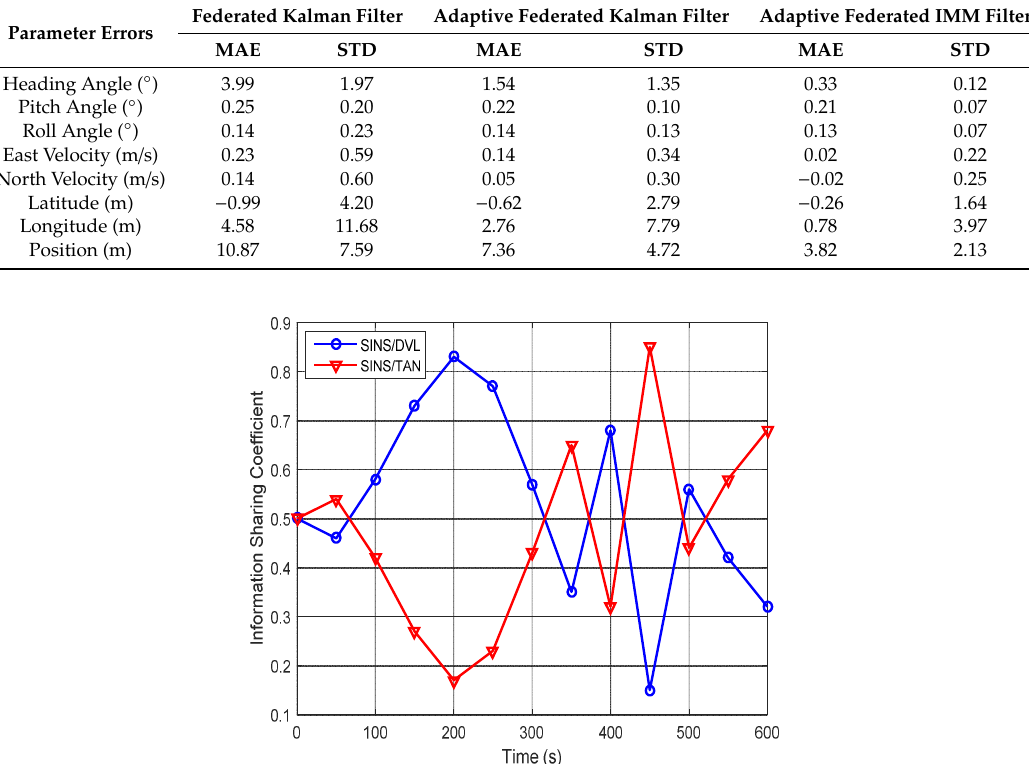
Figure 21. The estimation curves of position error. Table 2. The mean absolute errors (MAEs) and standard deviations (STDs) of integrated navigation errors by the three filtering methods.